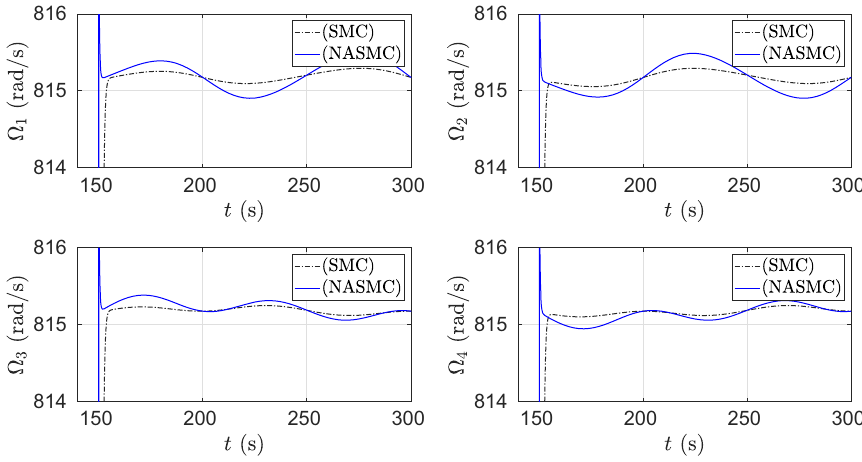
Figure 10: Rotor angular speeds of the quadcopter system using SMC and NASMC ( the second 150 s of simulations ) .